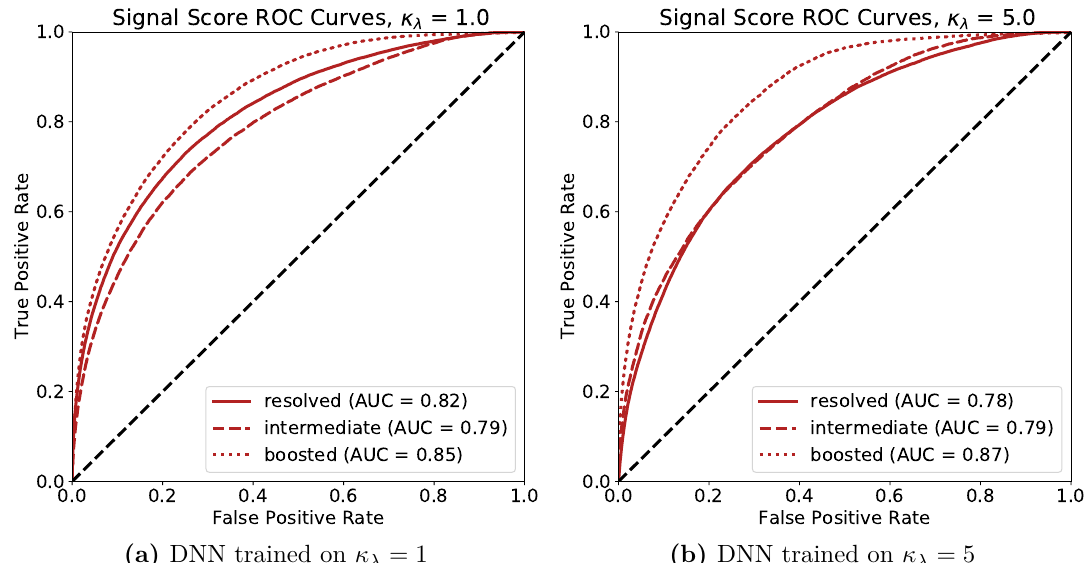
Figure 19. Receiver operator characteristic (ROC) curves for the DNN trained on (a) κ λ = 1 and (b) κ λ = 5 . These quantify true positive vs false positive classification rates for the signal events in the resolved (solid), intermediate (dashed), and boosted (dotted) categories. Values for the area under the curve (AUC) are displayed in the